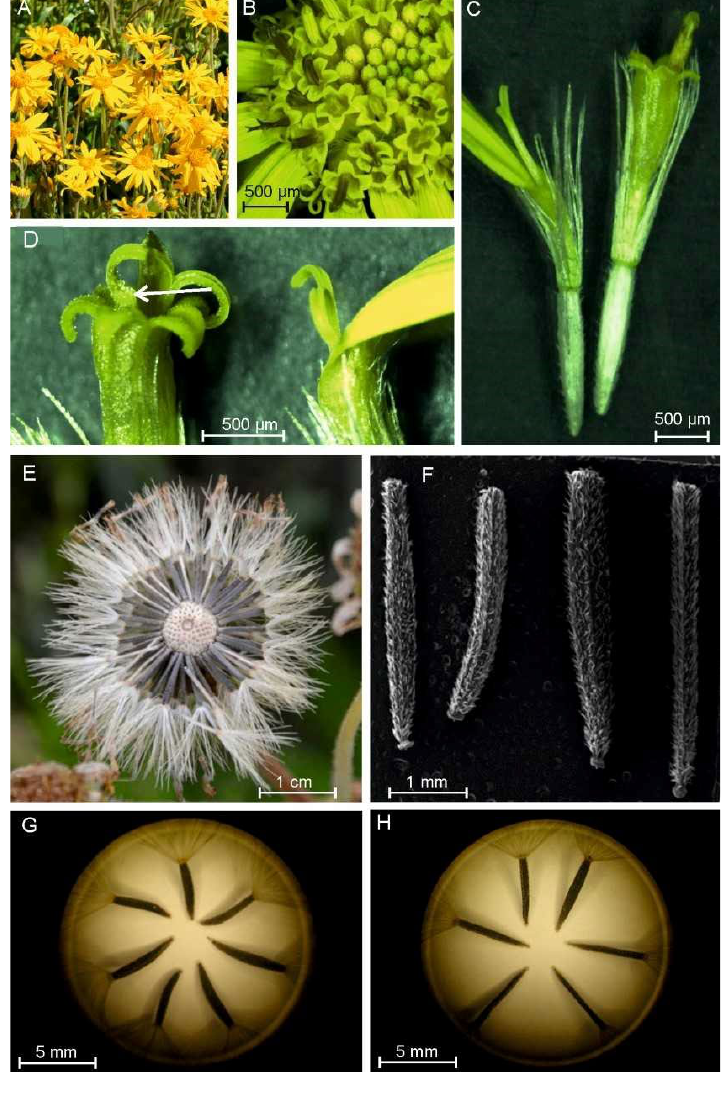
Figure 1. Specimens of Arnica montana L. in the full flowering phase ( A ). A. montana inflorescence at the anthesis stage; centripetal direction of opening of individual flowers in the inflorescence ( B ). Morphological diversity of flowers in the inflorescence: left—ligulate ray floret; right—tubular disc floret ( C ). Top part of the pistil in the two types of flowers with visible pollen grains (see arrow) deposited on the stigma surface ( D ). Achenes in infructescence—dead seeds are white, while viable seeds are dark grey ( E ). Morphological diversity of achenes: achenes obtained from ray (( F )—left site, ( G )) and disc florets (( F )—right site, ( H )).